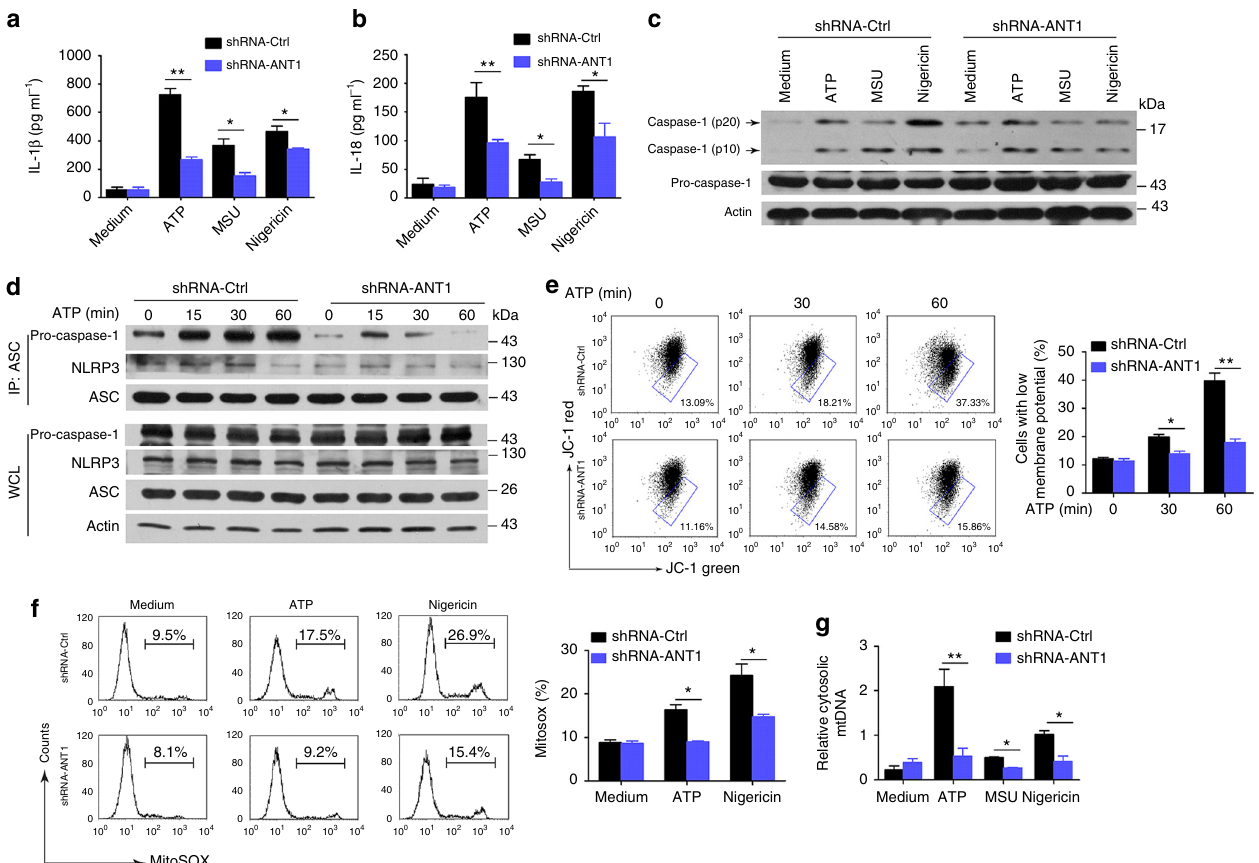
Fig. 7 ANT1 knockdown suppresses activation of NLRP3 in fl ammasome. Two groups of THP-1-derived macrophages, i.e., with shRNA-Ctrl or shRNA-ANT1, were primed with 100 ng ml − 1 LPS for 3 h, and then stimulated with ATP (5 mM, 1 h), MSU (500 µ g ml − 1 , 2 h), or Nigericin (10 µ M, 2 h), respectively. a , b ELISA of IL-1 β and IL-18 in the culture supernatant. c Immunoblot analysis of cell lysates from THP-1-derived macrophages. d Immunoblot analysis of Co-IP from THP-1-derived macrophages. e , f Flow cytometry analysis of mitochondrial membrane potential by JC-1 staining e or mitochondrial ROS by MitoSOX staining f from THP-1-derived macrophages with shRNA-Ctrl or shRNA-ANT1 lentivirus, followed by LPS treatment and ATP or Nigericin stimulation. g Quantitative real-time PCR analysis of mtDNA released from ANT1-knockdown THP-1-derived macrophages and left unstimulated (medium) or primed with LPS and stimulated with ATP, MSU or Nigericin. * P < 0.05, ** P < 0.01, one-way ANOVA for multiple comparisons. Data are representative of three independent experiments (mean and SEM of three independent samples in a , b , e – g